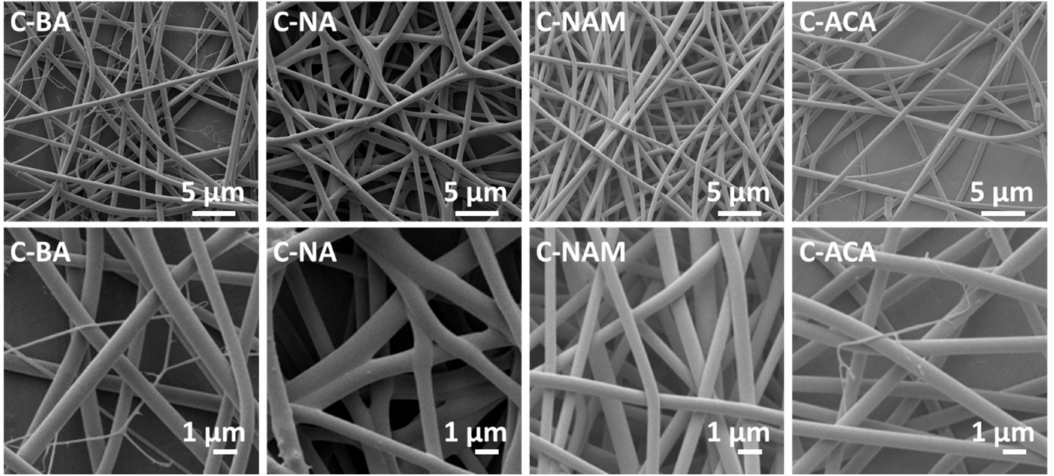
Figure 5. SEM images of the coaxial